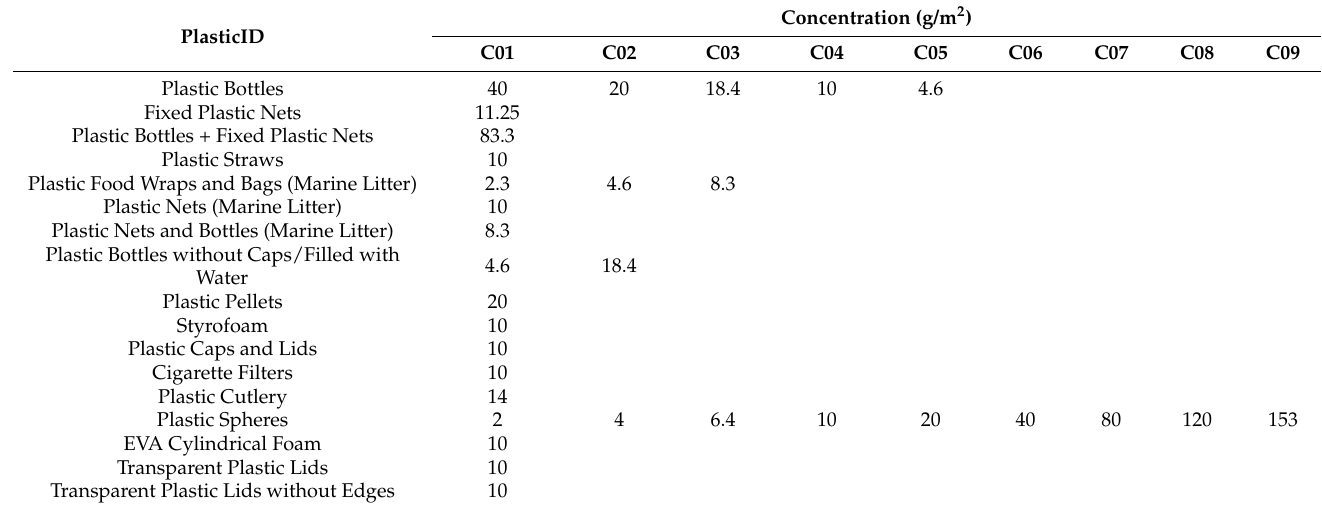
Table 2. Applied concentrations in the test campaigns. Cx corresponds to different